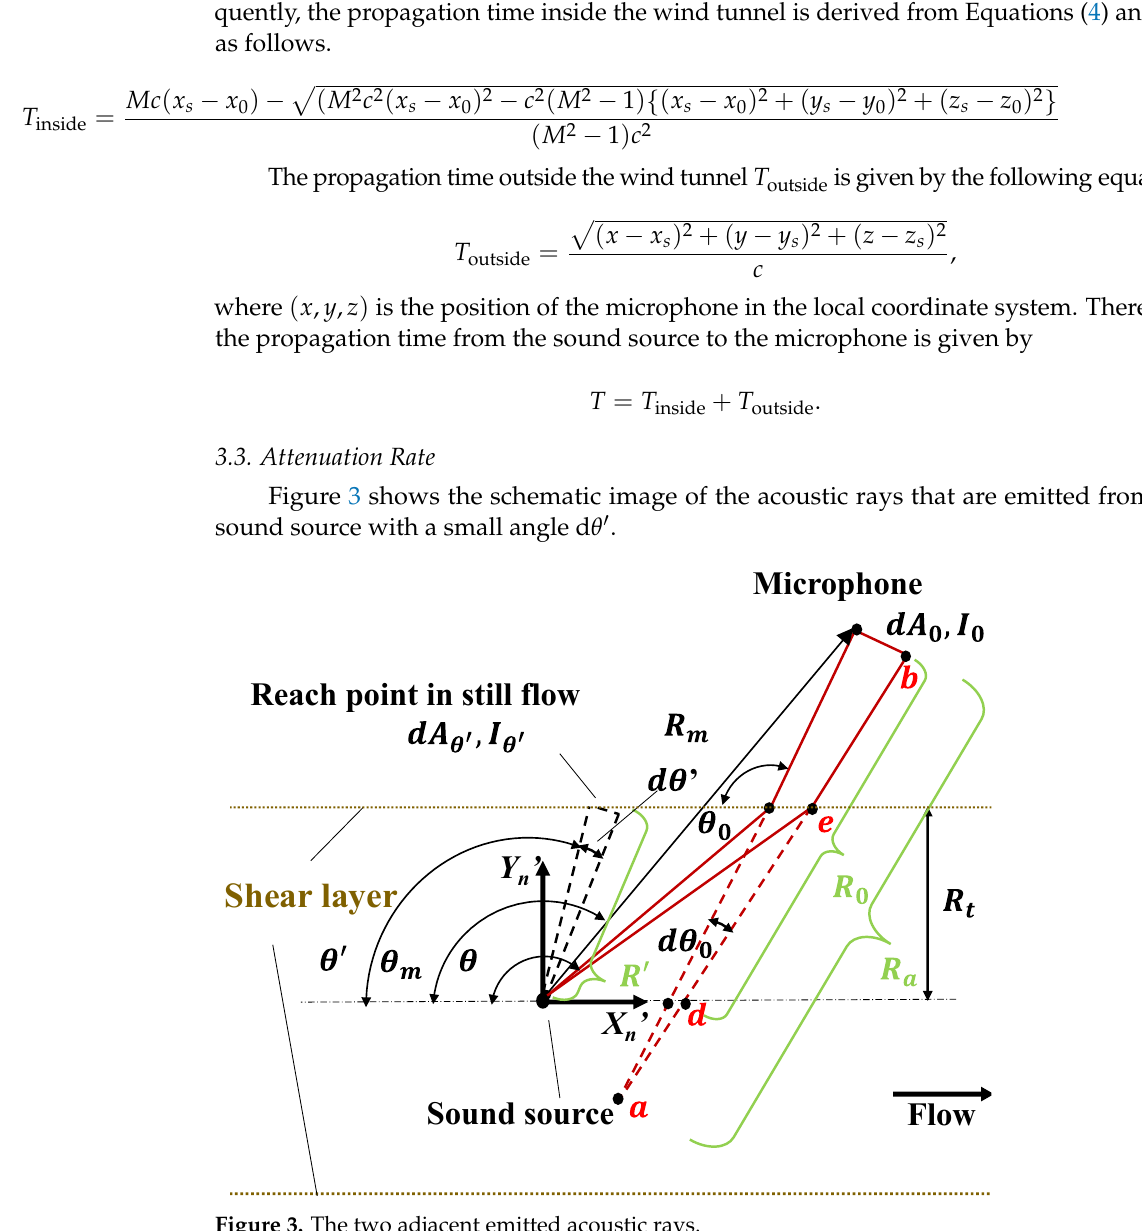
Figure 3. The two adjacent emitted acoustic